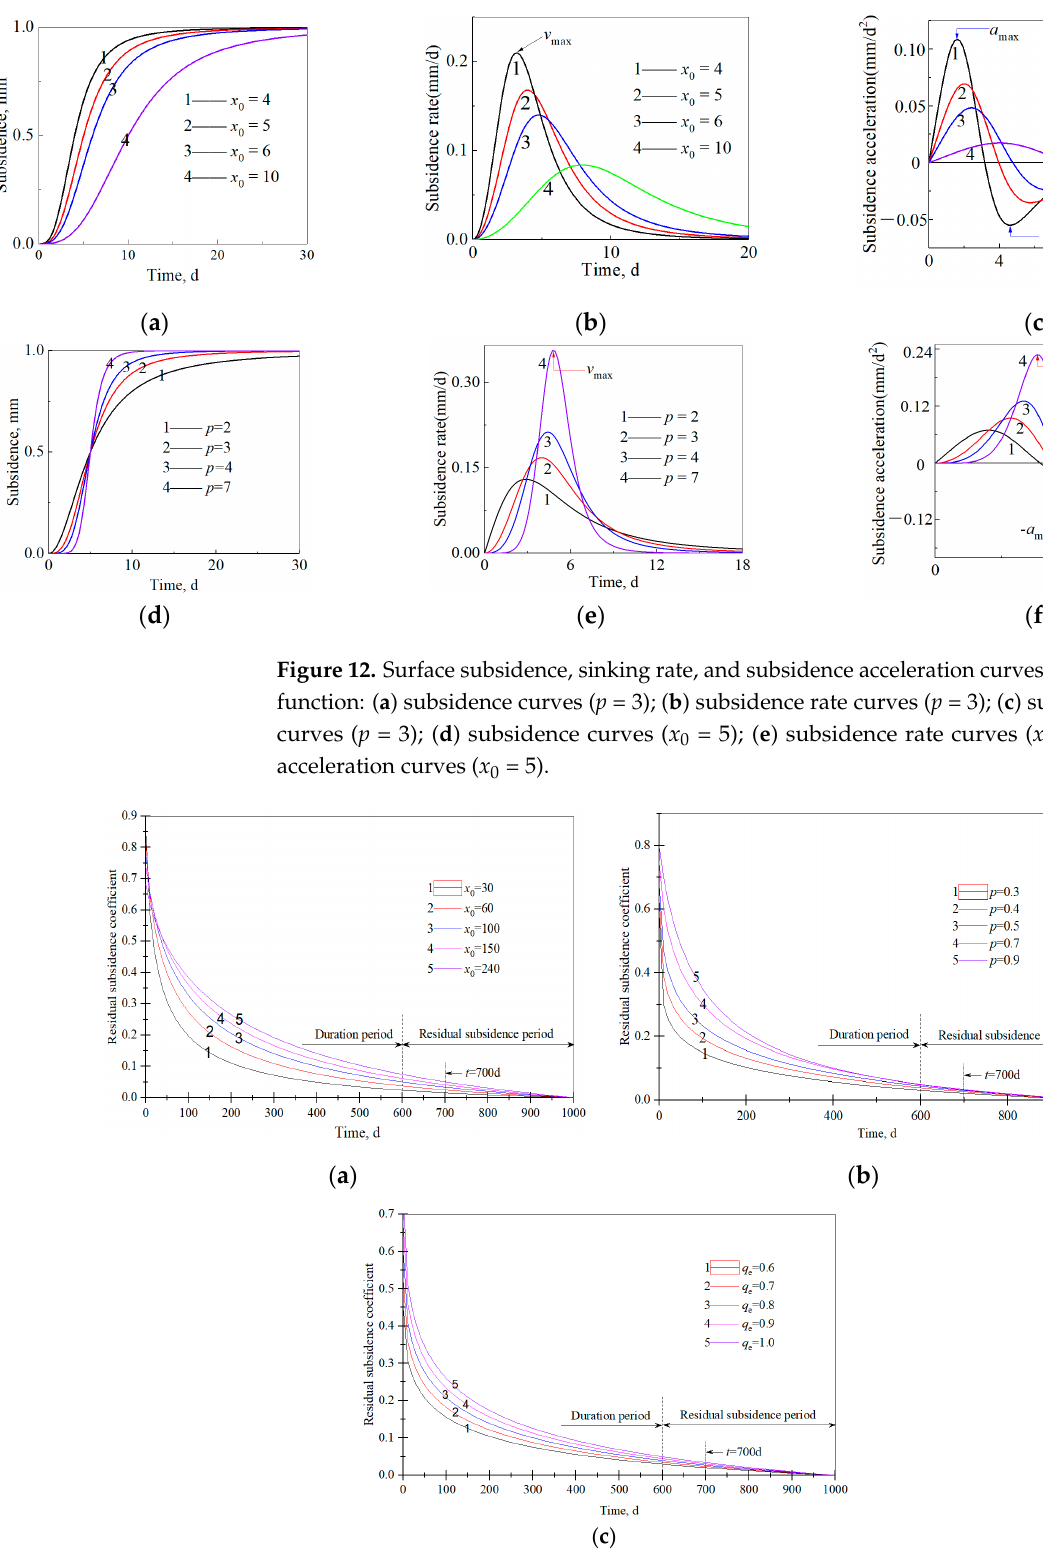
Figure 12. Surface subsidence, sinking rate, and subsidence acceleration curves based on logistic time function: ( a ) subsidence curves ( p = 3); ( b ) subsidence rate curves ( p = 3); ( c ) subsidence accel- eration curves ( p = 3); ( d ) subsidence curves ( x 0 = 5); ( e ) subsidence rate curves ( x 0 = 5); ( f ) subsidence acceleration curves ( x 0 = 5).